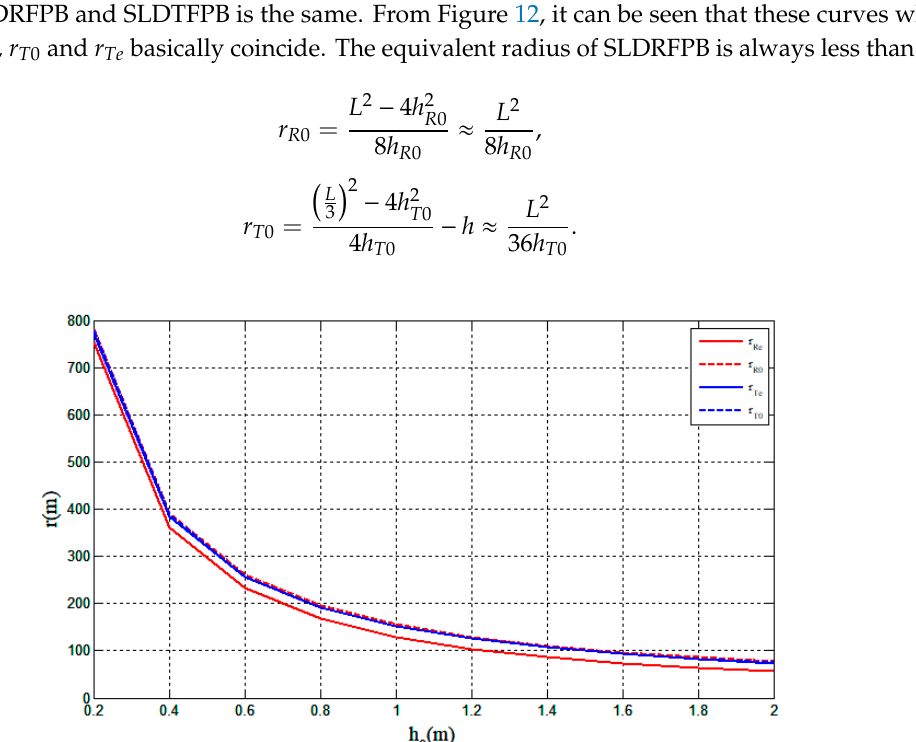
Figure 12. Equivalent radii of isolation systems equipped with SLDRFPB and SLDTFPB, respectively.